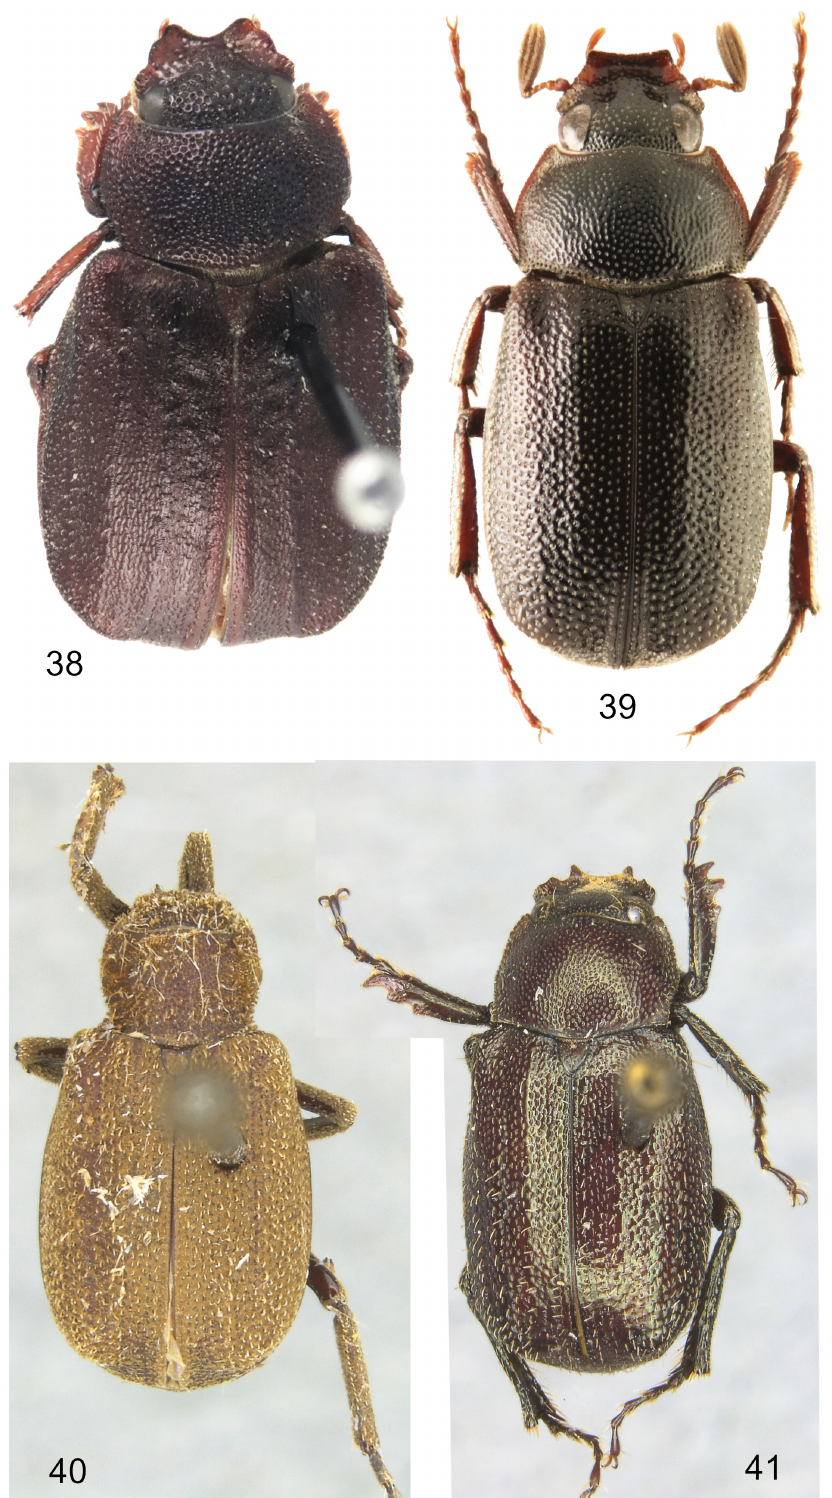
Figs 38–41. Papuan Maechidius Macleay, 1819, habitus, dorsal view. 38 . M. fraterculus Moser, 1920, lectotype, ♀ (ZMHB). 39 . M. hamatus sp. nov., holotype, ♂ (IECA). 40 . M. helleri (Frey, 1969) comb. nov., holotype, ♂ (BPBM) (photograph courtesy BPBM). 41 . M. gressitti Frey, 1969, holotype, ♂ (photograph courtesy BPBM) (BPBM). Not to